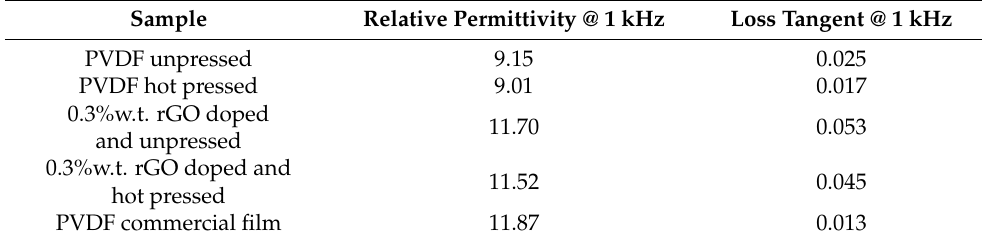
Figure 8. Micrographs showing frequency sweeps of ( a ) relative permittivity, and ( b ) dielectric loss tangent of PVDF samples. Table 2. Extracted dielectric attributes of PVDF